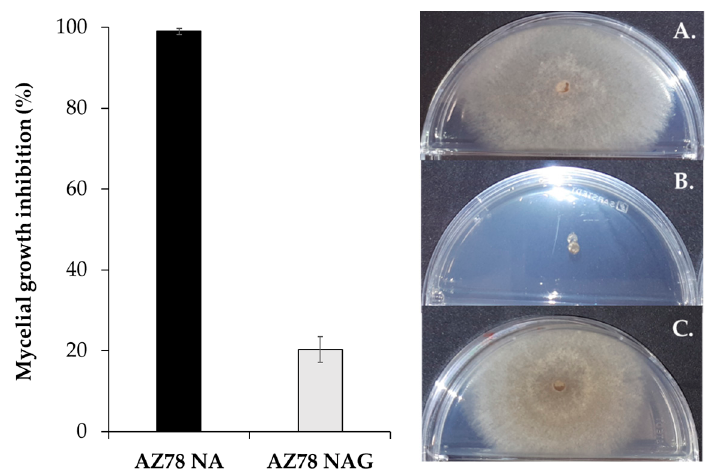
Figure 1. Inhibition of Rhizoctonia solani growth by Lysobacter capsici AZ78 volatiles emitted on di ff erent growth media. The side where R. solani had been grown is illustrated: ( A ) Control, not inoculated with AZ78; ( B ) AZ78 on Nutrient Agar and ( C ) AZ78 on Nutrient Agar amended with d -Glucose (20 g / L). 3.2. Pyrazines Are Involved in the Inhibition of Rhizoctonia solani Growth by Lysobacter capsici AZ78 Grown on Protein-Rich